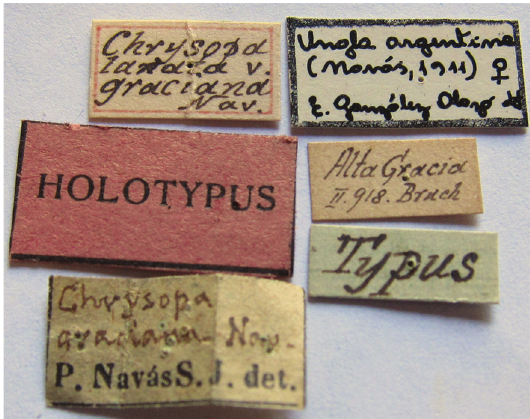
Figure 141. Chrysopa graciana Navás: Labels from type (Argentina, Córdoba, MACN).